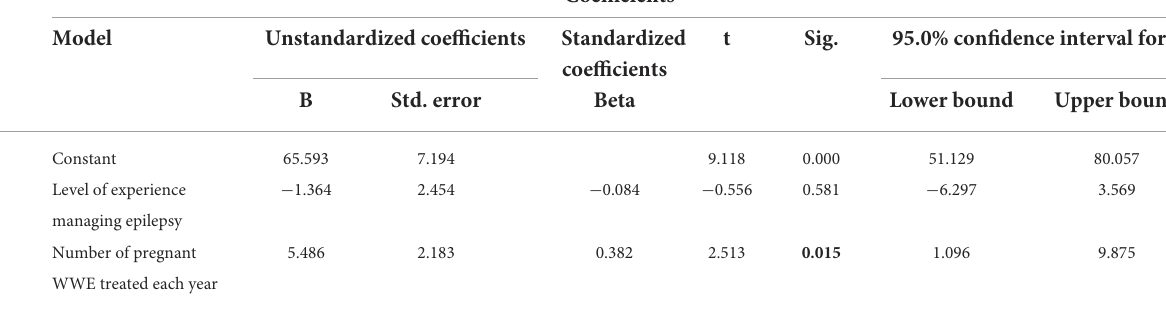
TABLE 6 Independent correlates of neurologists ’ knowledge after multivariate linear regression